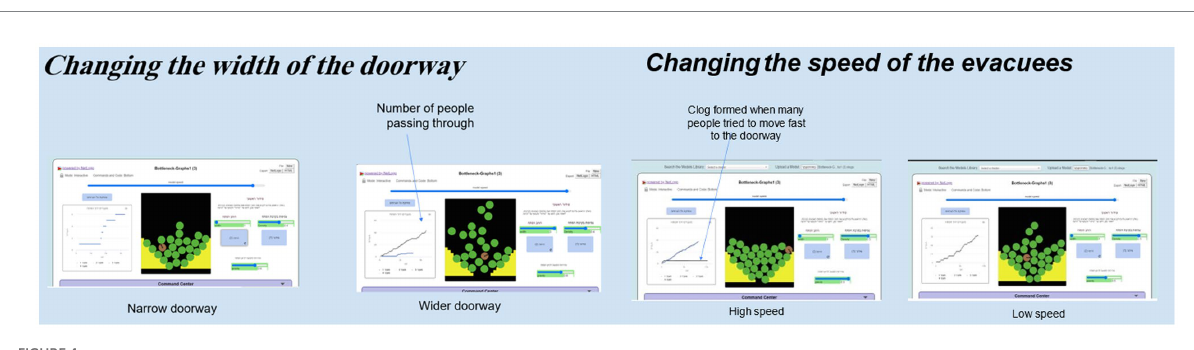
FIGURE 4 Two slides from the presentation shown to both groups, that shows the bottleneck simulation: the width of the doorway (left) and the influence of speed (right) on the passing